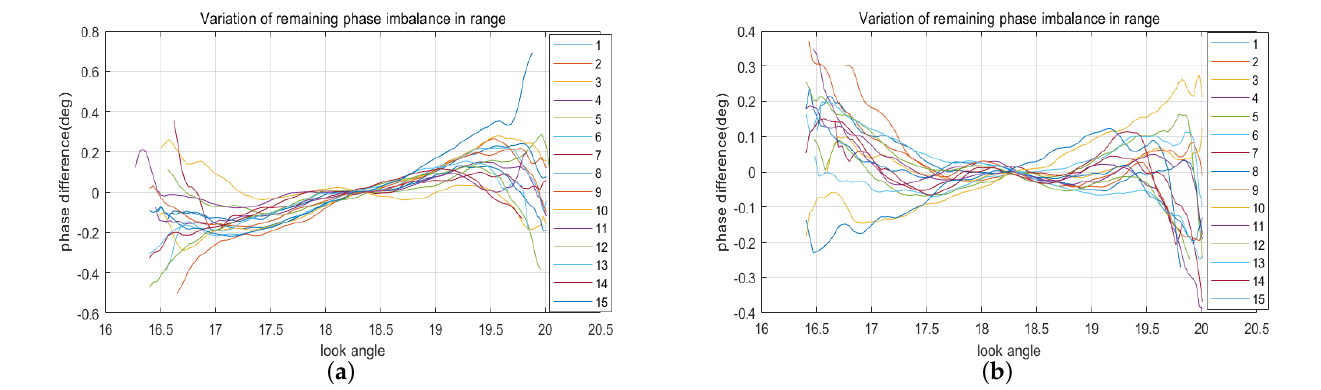
Figure 11. The relative change of phase imbalances in range after removing the phase imbalance caused by squint imaging. ( a ) The first set of GF-3 ATI data; ( b ) the second set of GF-3 ATI